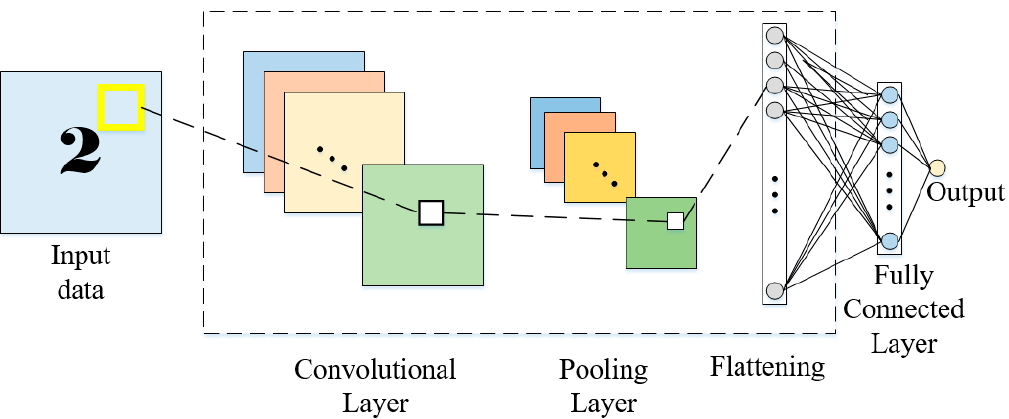
Figure 3. Example structure for a convolutional neural network.